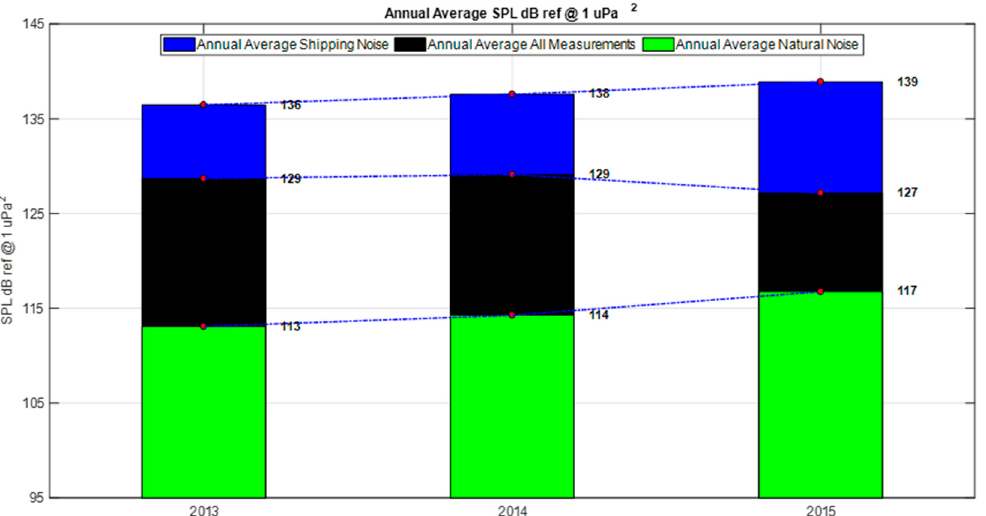
Figure 13. Annual average of the maximum ( left ) and mean ( right ) levels of the 1/3 octave band centered at 125 Hz of the three groups of measurements according to the identification of the acoustic sources.